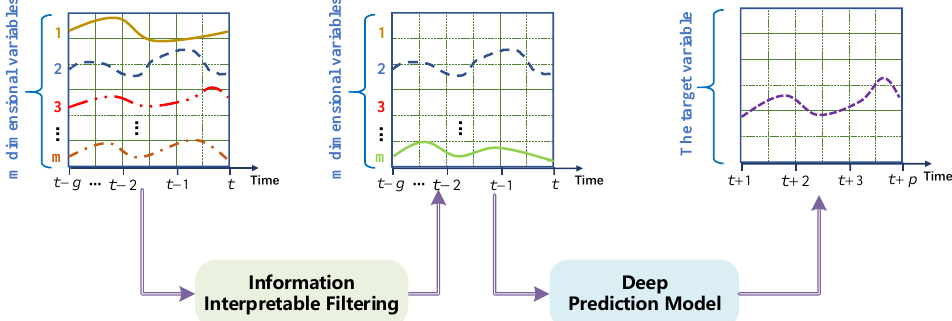
Figure 2. A deep forecasting model based on information interpretability filtering (m < n). The dotted lines with different colors in the figure represent different variables.